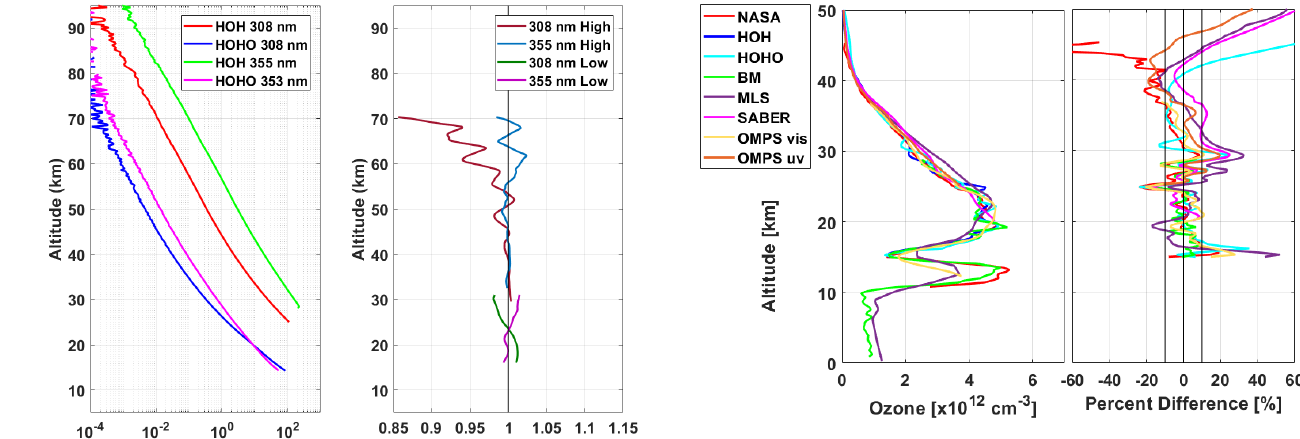
Figure 4. Ozone profiles measured by the NASA-STROZ (red), HOH (blue), and HOHO (cyan) lidars, locally launched ozonesonde (green), and overpasses from SABER (magenta), MLS (violet), OMPS VIS (mustard), and OMPS UV (burnt orange) on the night of 6 April 2019. Percent differences are with respect to the HOH